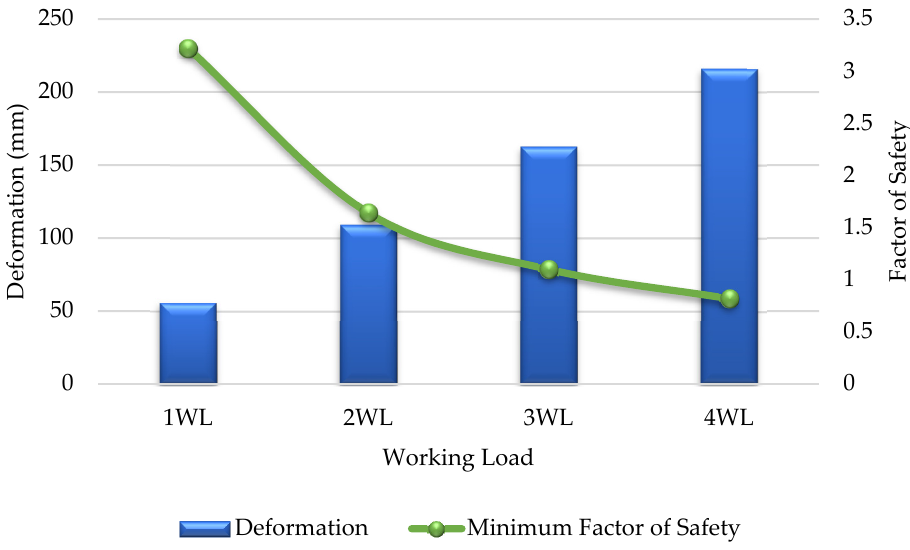
Figure 10. Deformation and Factor of Safety (FOS) for GFRP cross-arm (broken wire condition).